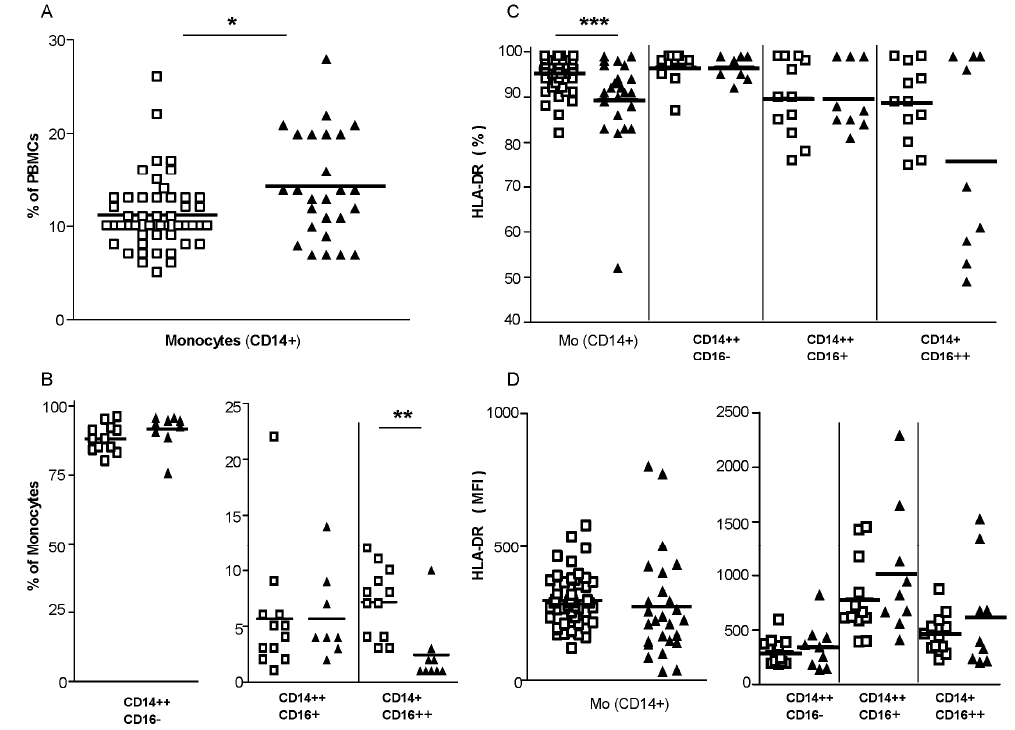
Figure 1. Changes in blood monocytes during TOSV infection. Peripheral blood mononuclear cells (PBMCs) from the study participants were stained with monoclonal antibodies for subsequent flow cytometric analyses. Monocytes (CD14 + ) were gated as described in Materials and Methods. Cell frequencies ( A , B ) and human leukocyte antigen (HLA)-DR expression levels ( C , D ) of the circulating monocytes are reported. N = 26 TOSV+ patients and n = 49 healthy controls were evaluated for total monocytes, while n = 9 TOSV+ patients and n = 12 healthy donors were analyzed for monocytic subsets. White squares indicate healthy controls and black triangles indicate TOSV-infected patients. MFI, mean fluorescence intensity. Data were analyzed using the non-parametric Mann–Whitney U test. * indicates p ≤ 0.05, ** indicates p ≤ 0.01 and *** indicates p ≤ 0.001.